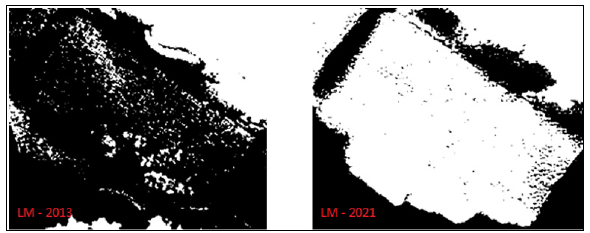
Figure 2: Google Earth Pro images showing the mangrove plot at Le Morne plot S5 (2013 and 2021) after image processing for estimating percentage canopy cover.